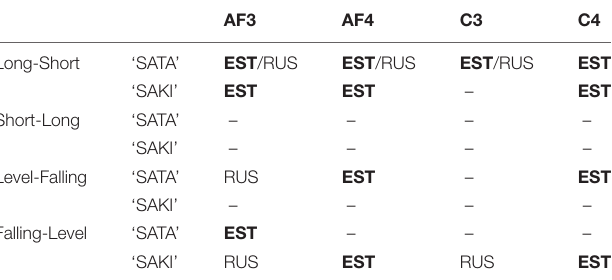
Est, Estonian; RUS, Russian. GAMM, Generalized Additive Mixed effects